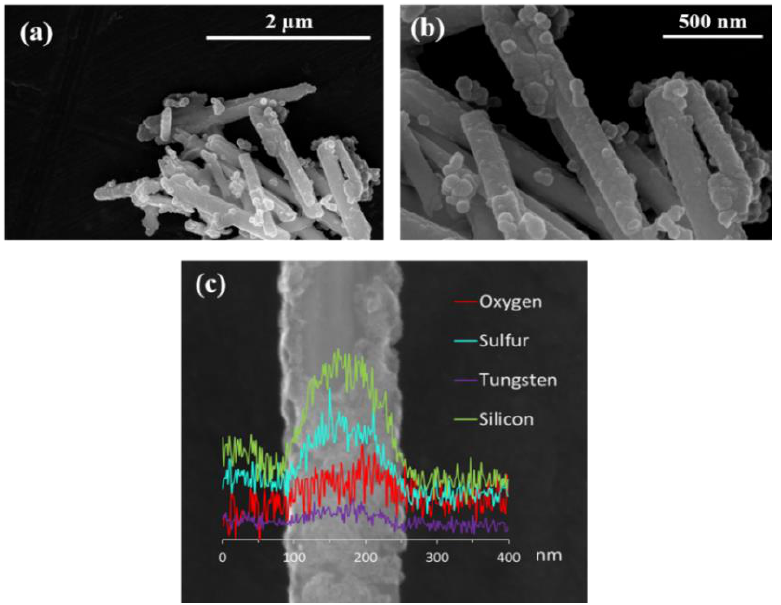
Figure 3. High-resolution scanning electron microscopy (HRSEM) images ( a , b ) and energy dispersive X-ray spectroscopy (EDS) line scan ( c ) of sample INT-SiO 2 -1P.